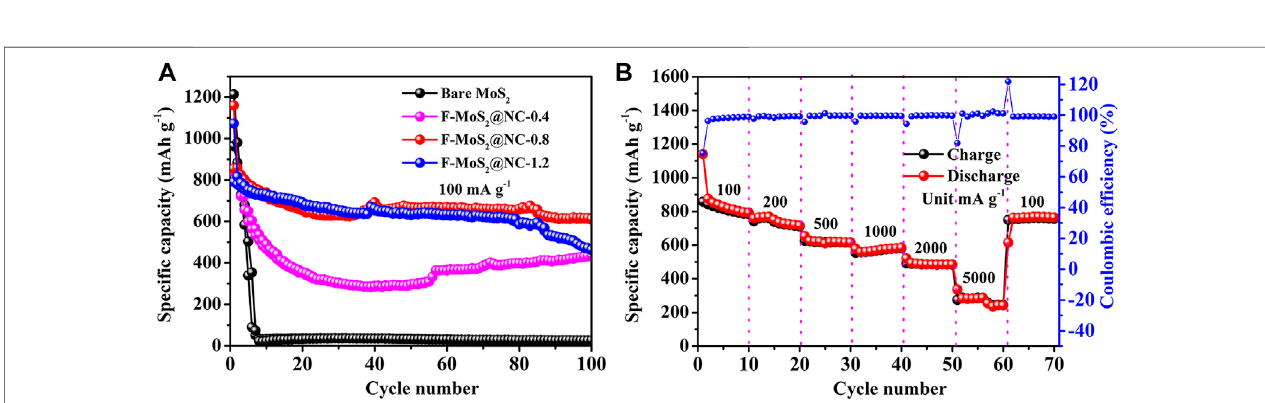
FIGURE 6 | Electrochemical performance of F-MoS 2 @NC as anode of LIBs: (A) Cycle performances of bare MoS 2 , F-MoS 2 @NC-0.4, F-MoS 2 @NC-0.8 and F-MoS 2 @NC-1.2 at a current density of 100 mA g − 1 . (B) Rate performance of F-MoS 2 @NC-0.8